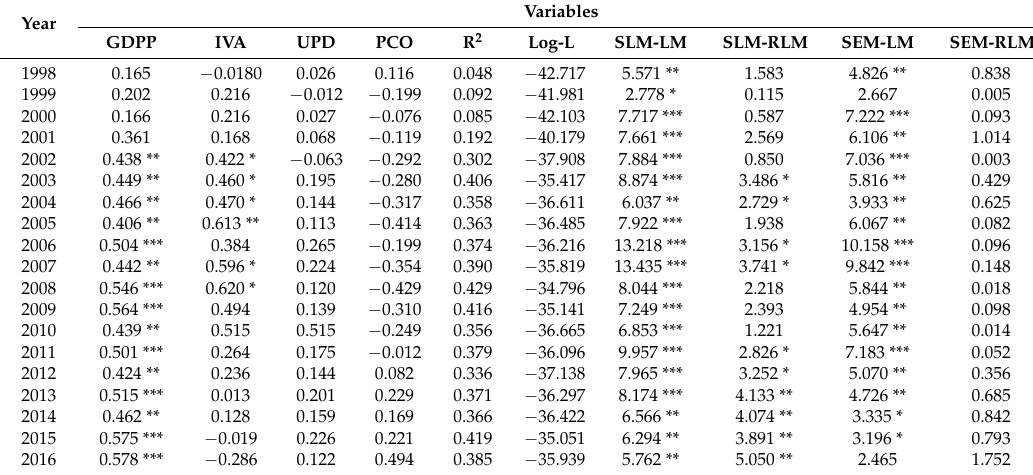
Table 3. Results of ordinary least squares regressions between PM 2.5 and socioeconomic factors in Mainland China,